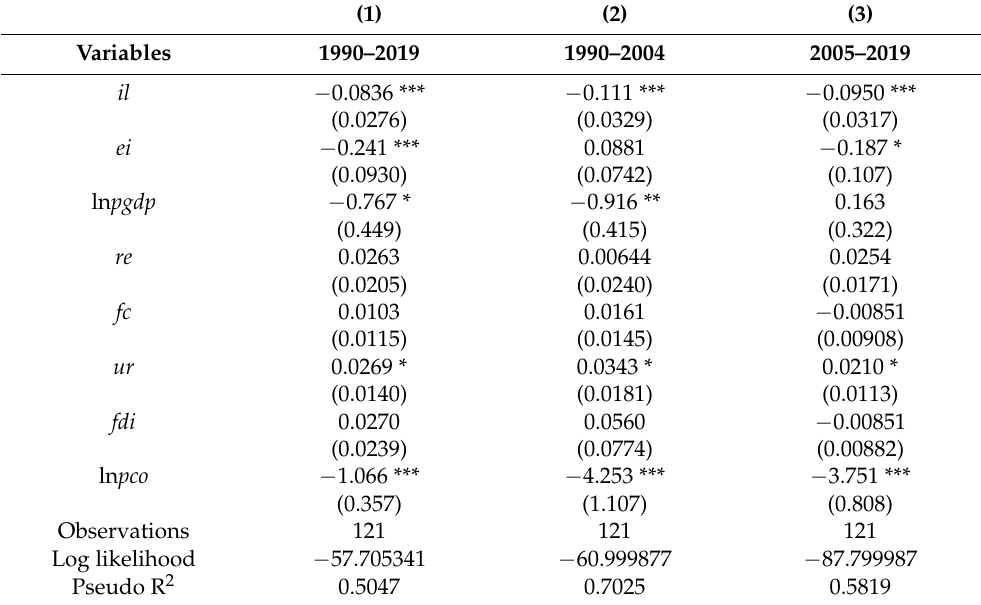
Table 5. The estimated results of the ordered logit